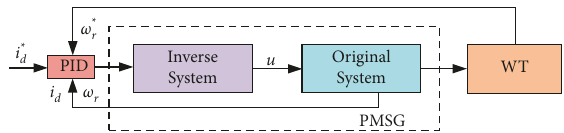
Figure 5: Control block diagram of the maximum wind-energy capture controller based on the inverse